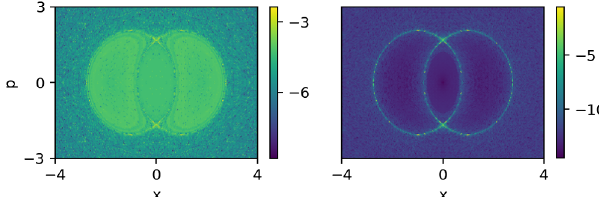
FIG. 8. Dynamic aperture plot using FMA and REM for the tune depression ratio η ¼ 0 . 8 and mismatch X ð 0 Þ ¼ 0 . 651 . The data is taken at every minimum of the envelope for the first 256 times forward and additional 256 times forward to evaluate Δ . Similarly, Δ is measured after 256 times forward and FMA REM then 256 times backward of the envelope period.